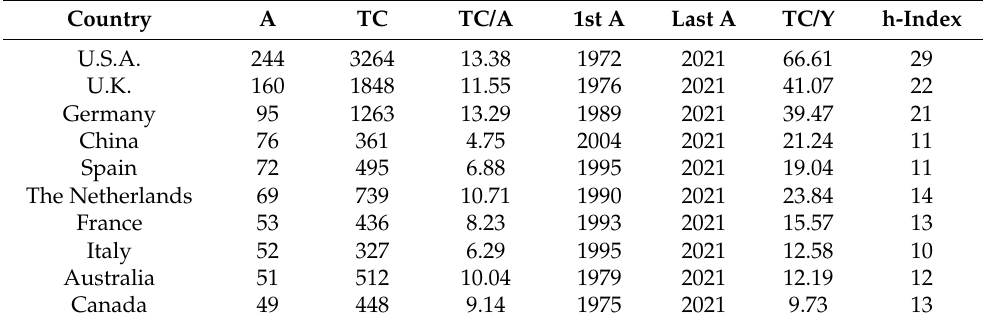
Table 4. The top 10 most productive countries on pension research.